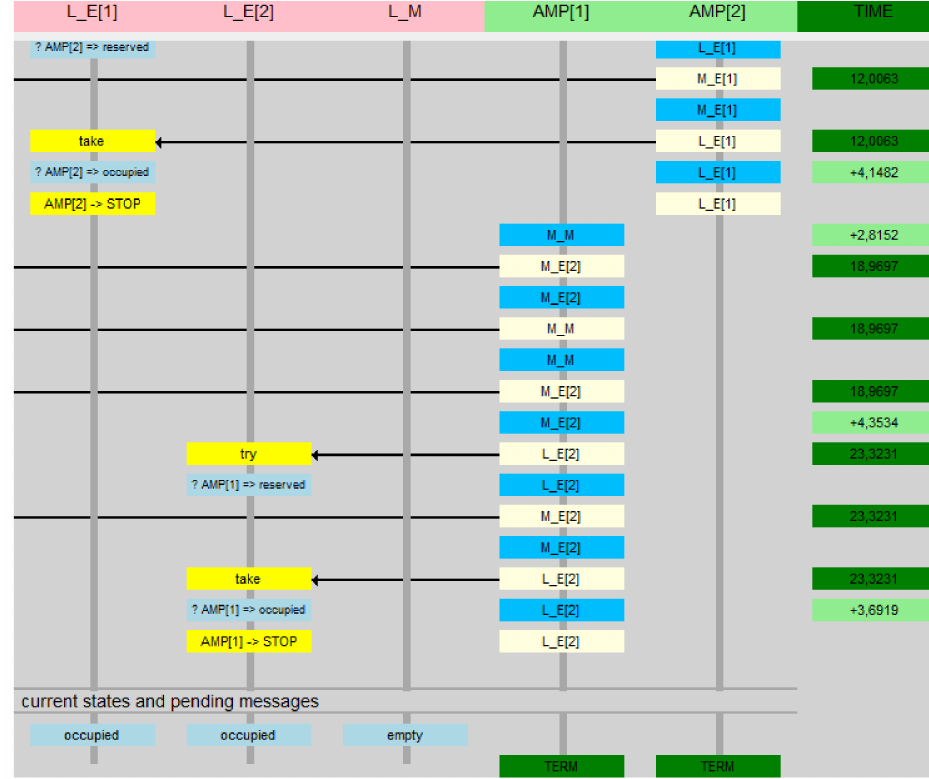
Figure 13. The final fragment of the witness of the corrected AVGS timed